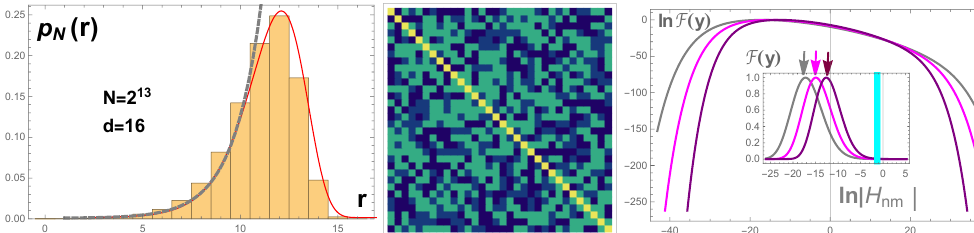
Figure 6: (Color online)(Left panel) The distribution of distances on RRG . The probability of large distances r grows exponentially like K r (gray dashed line) until ≈ d ≈ ln N / ln K . (Middle panel) The matrix it reaches the maximal value r max of distances on RRG. Large distances r ≈ d constitute a finite fraction of all the distances between two vertices. In each row of the distance matrix on RRG there are ∼ N matrix elements (shown in dark blue on right panel) which correspond to pairs of vertices with large distances r ≈ d between them. These “halo” sites are connected by multiple loops on RRG. The sites with small distances r (cid:174) d can be considered as a “medium” through which an effective hopping between the “halo” sites occurs in the high-order of perturbation theory in the nearest neighbor hopping on RRG. These sites form an almost loop-less, tree structure which allows to compute the distribution function of i.i.d. effective large-distance hopping matrix elements between the “halo” sites. We conjecture that the Rosenzweig-Porter random matrix model obtained by completing the random matrix of effective hopping over the “halo” sites to full matrix (complete graph) captures all the essential large-distance features of the Anderson | at N = 2048 model on RRG. (Right panel) Logarithm of distribution of ln | H nm (purple), 8192 (magenta), 32768 (gray) for W = 12. The arrows show the typical | . The inset shows F ( y = ln | H | ) with the cyan strip indicating value of ln | H nm nm | which is relevant for the eigenfunction statistics and dynamical the region of ln | H nm properties. All energies are measured in units of the total spectral bandwidth E BW